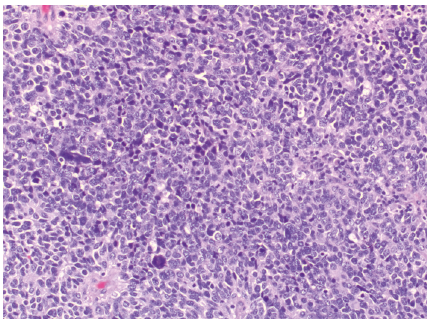
Figure 4: Histological examination shows solid infiltration of small/intermediate neoplastic cells displaying round hyperchro- matic pleomorphic nuclei with indistinct cytoplasm and brisk mitotic activity (Hematoxylin & eosin, original magnification